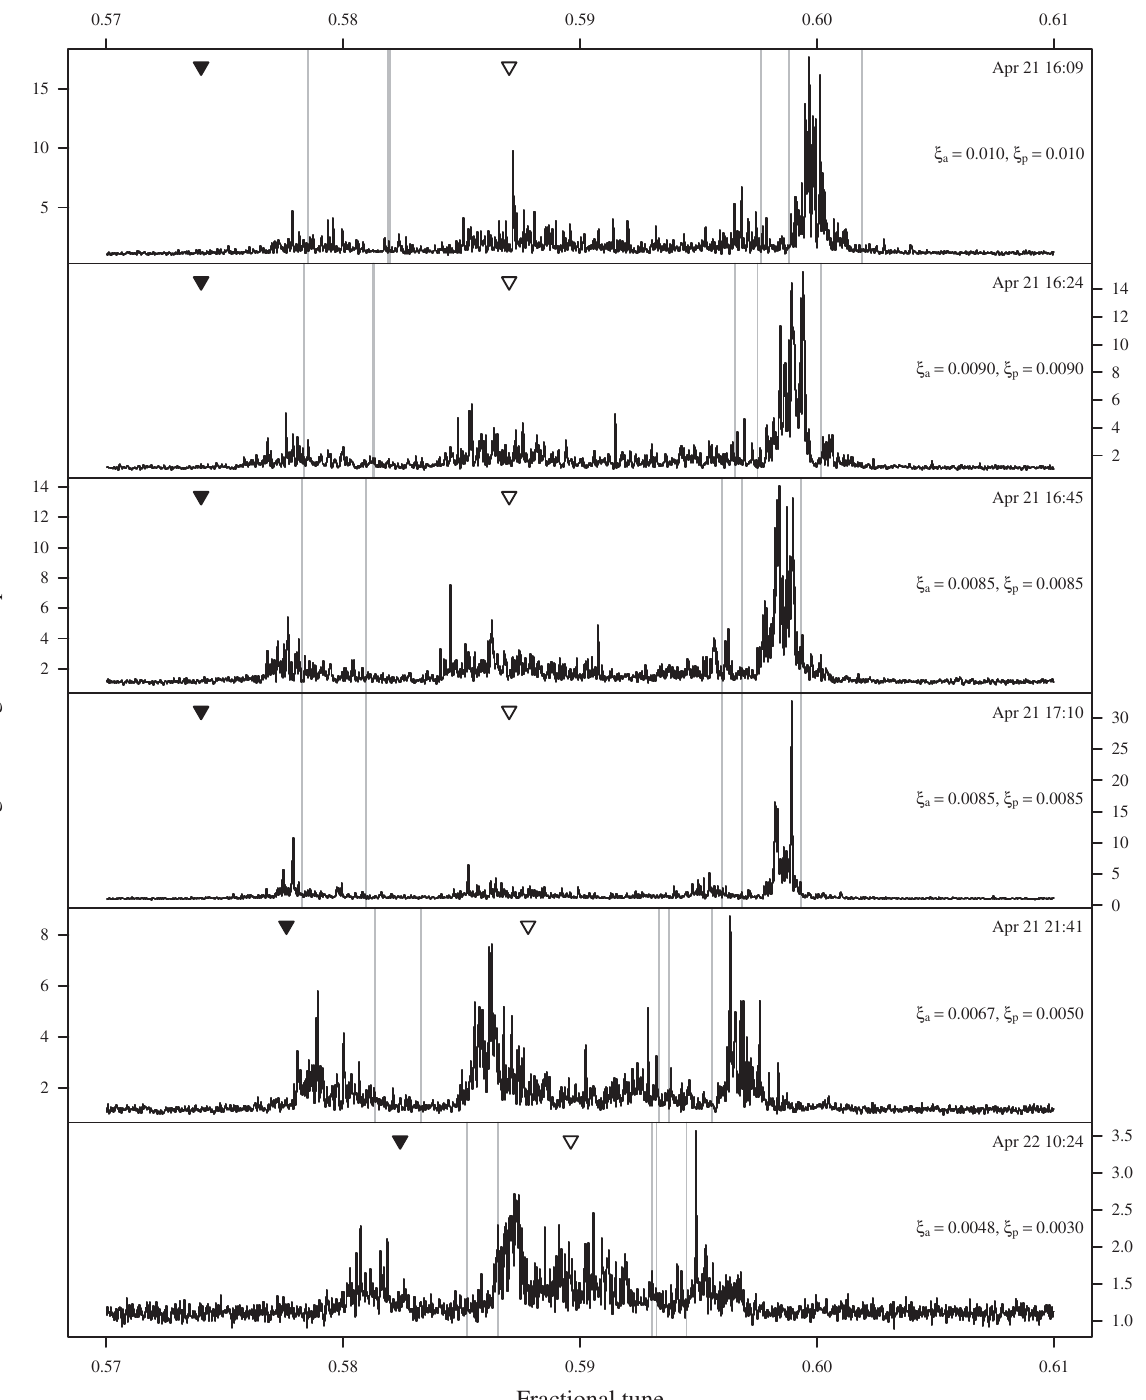
FIG. 13. Evolution of vertical coherent beam-beam modes for antiproton bunch A13 during the course of Store